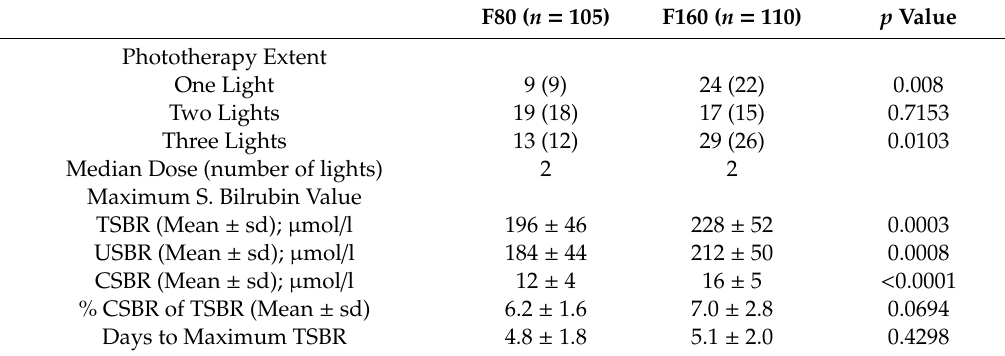
Table 4. Jaundice Outcomes.